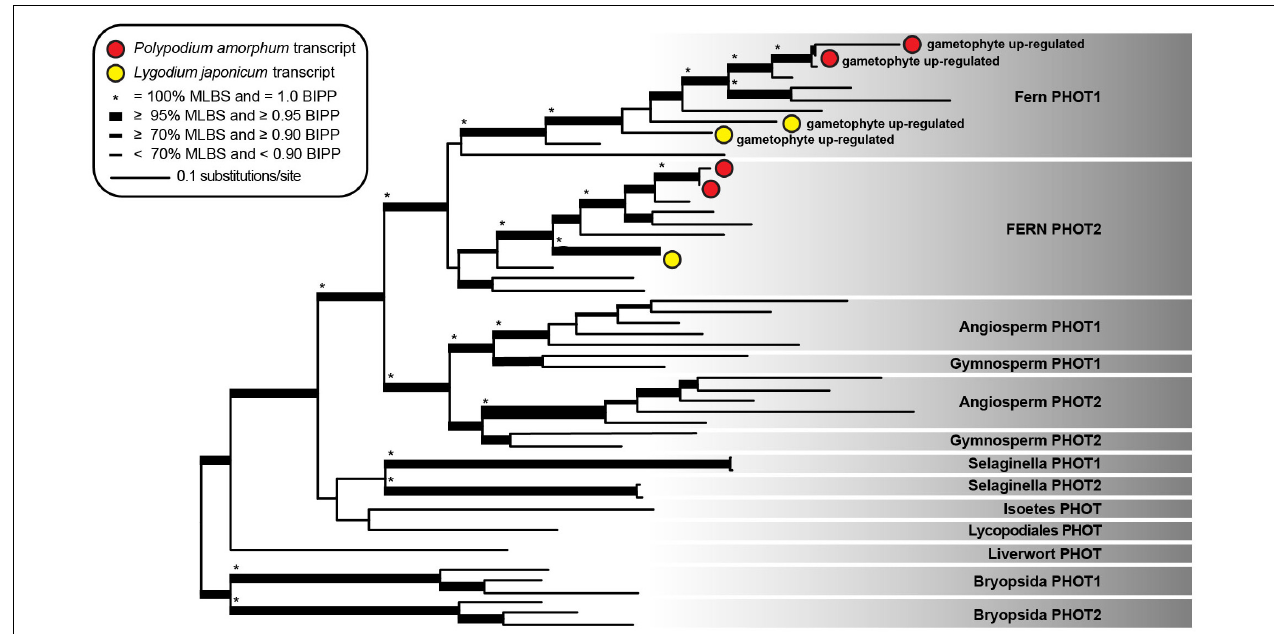
FIGURE 6 | Phylogram of the best maximum likelihood tree of phototropin sequences. Shading indicates taxonomic specific phototropin clades as described in Li et al. (2015). Red and yellow circles represent single transcripts from the ferns Polypodium amorphum and Lygodium japonicum , respectively, that are up-regulated in the gametophyte phase. Node support values are as indicated in the inset legend. MLBS, maximum likelihood bootstrap value; BIPP, Bayesian inference posterior